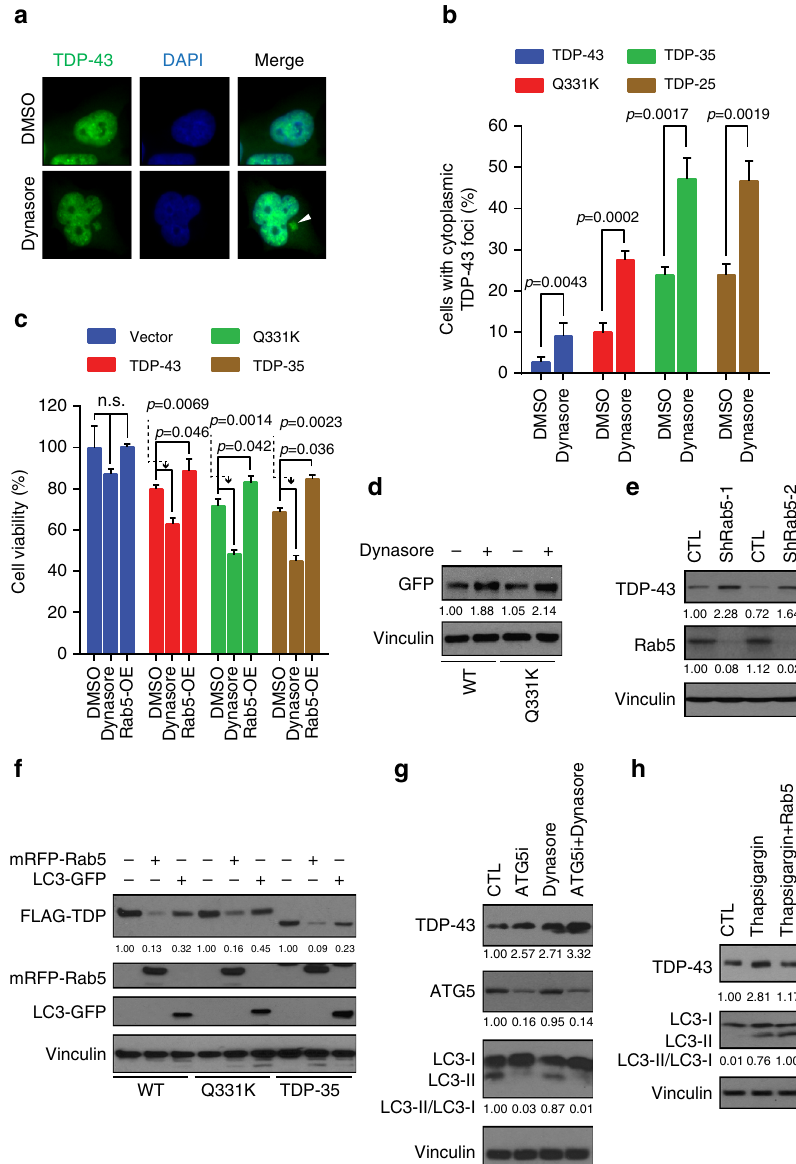
Fig. 6 Endocytosis and autophagy affect TDP-43 degradation. a , b HEK293A cells were transfected with TDP-43 WT-, TDP-43 Q331K-, TDP-35-, or TDP-25- GFP and treated with 40 µ M dynasore for 24h. Immuno fl uorescence was performed; TDP-43-GFP shown in a . Arrowhead indicates TDP-43 cytoplasmic foci. Scale bar = 5 µ m. Percentage of cells with cytoplasmic foci quanti fi ed in b . Signi fi cance was assessed by two tailed Student ’ s t test. Repeated data are shown as mean ± s.e.m. c Stable HEK293A cell line including vector, WT, Q331K, and TDP-35 were constructed, treated with or without 40 µ M dynasore or Rab5 overexpression and cell viability was compared after 48h. Signi fi cance was assessed by one-way ANOVA; n.s. = no signi fi cance. Data are shown as mean ± s.e.m. d HEK293A cells were transfected with TDP-43 WT and Q331K-GFP plasmids, treated with or without 40 µ M dynasore for 48h, then harvested and subject to western blotting and quanti fi cation of TDP-43 levels relative to a Vinculin loading control. e Endogenous TDP-43 expression level was detected and quanti fi ed in control (CTL) and Rab5 knock down cells as above. f Rab5 or LC3 was co-transfected with TDP-43 WT or Q331K plasmids. Cells were harvested after 48h culture and subject to western blotting and quanti fi ed as above. Note, higher-molecular weight bands in mRFP-Rab5 row, TDP-35 set (1st and 3rd column) are FLAG-TDP-35. g HEK293A cells were treated with ATG5 siRNA knockdown (ef fi ciency indicated in second row) and/ or 40 µ M dynasore for 24h. Endogenous TDP-43 and LC3 protein levels were examined and quanti fi ed as above. h HEK293A cells were treated with 0.3 µ M thapsigargin for 24h or combined with Rab5 transfection. Endogenous TDP-43 and LC3 protein levels were examined and quanti fi ed as